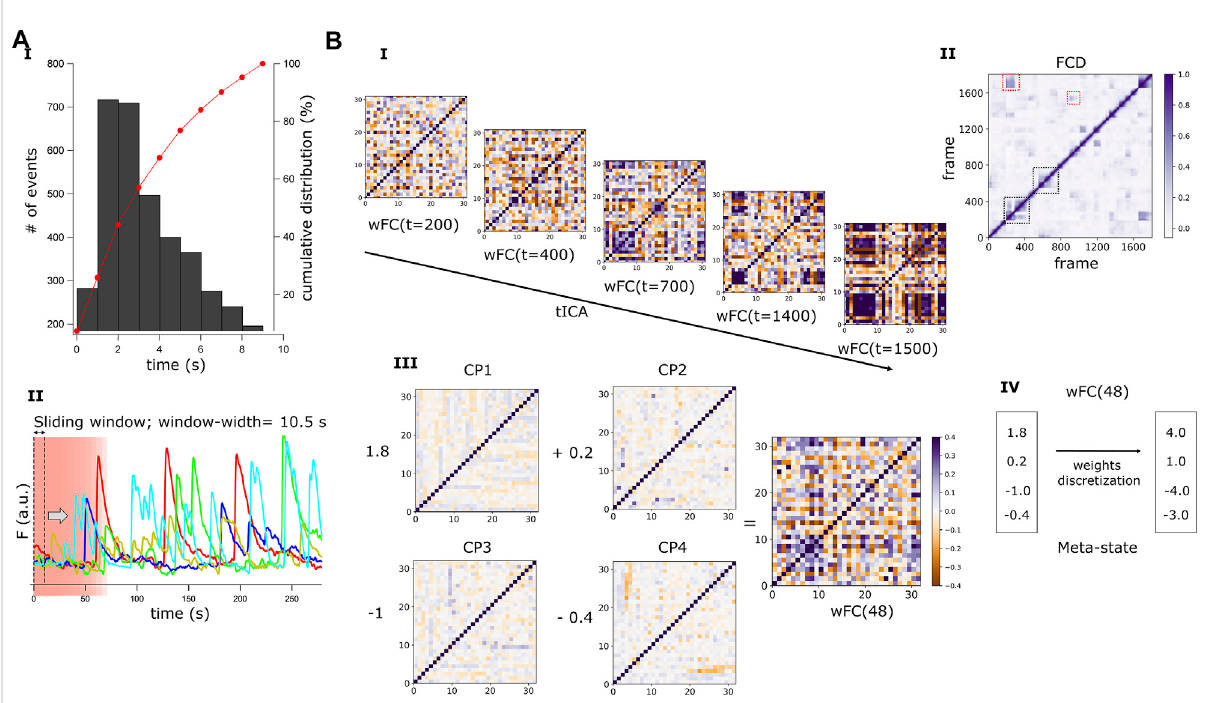
FIGURE 3 Dynamicsoftheresting-stateFCandde fi nitionofconnectivityMeta-states. (A) Graphicalrepresentationoftheslidingtime-windowcorrelation method. (A.I) Histogram showing the distribution of the transients half-widths for all detected Ca 2+ events (n = 5,246). The cumulative distribution (redcurve)depictsthatnoeventswithahalf-widthlongerthan10sweredetected. (A.II) Ca 2+